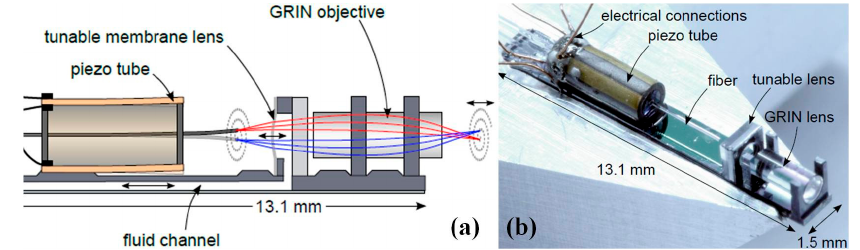
Figure 14. Tunable lens based three-dimensional confocal microscope. ( a ) Schematic drawing of the three-dimensional confocal micro-scanner with a laterally scanning fiber driven by a piezo tube, a tunable liquid filled lens and a GRIN lens, all mounted onto a Si micro-bench with fluidic structures for actuating the tunable lens. ( b ) Photograph of completely assembled probe with all components on the optical micro-bench (Reproduced with permission from IEEE [91]).